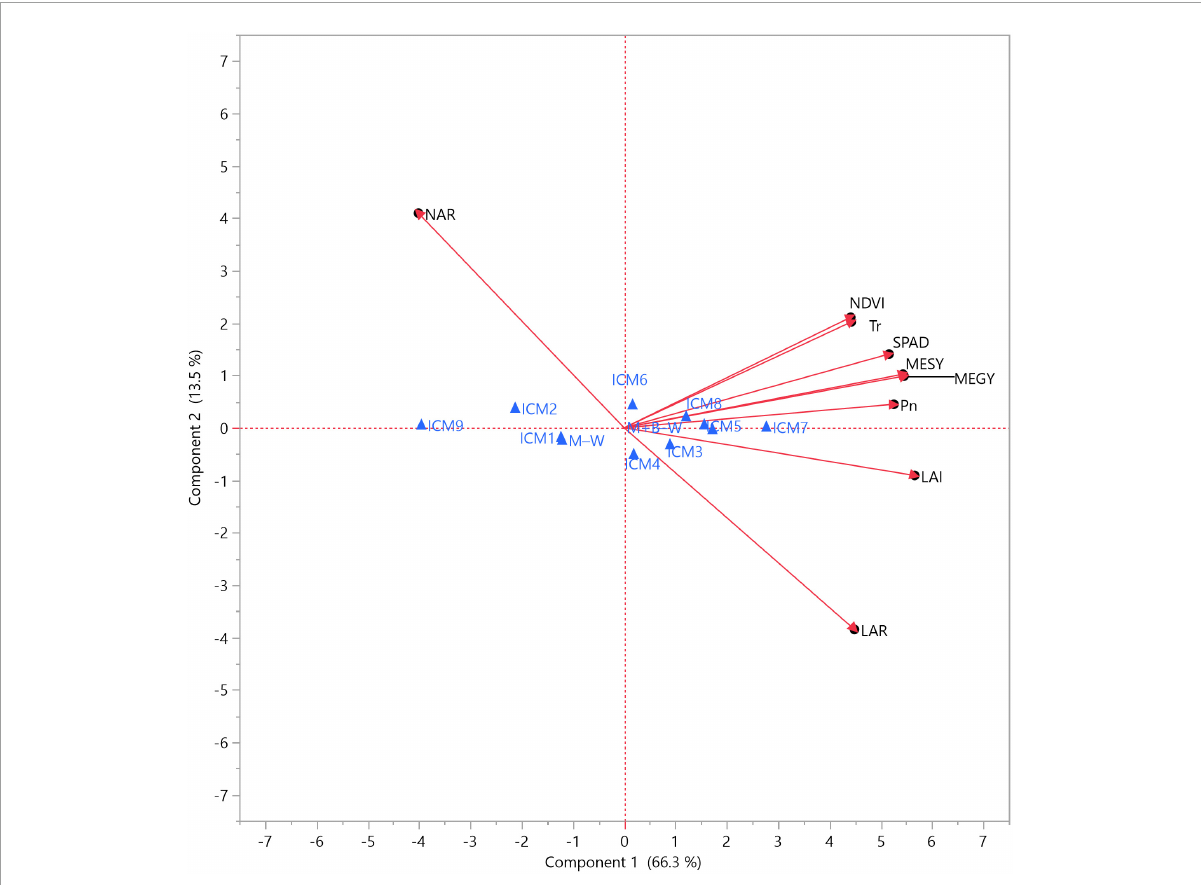
FIGURE6 Principal component analysis (PCA) biplots on impact of ICM and CS on various crop physiological (LAI, LAR, NAR, NDVI, and SPAD at 60 DAS) and photosynthetic characteristics (flowering stage, 60 DAS), MEGY and MESY in maize from two cropping seasons (2019 and 2020). Blue triangle indicates main- and subplot treatments, i.e., CT (ICM 1 –ICM 4 ), CA (ICM 5 –ICM 8 ), and OA (ICM 9 ); maize–wheat cropping system (M–W); maize + blackgram–wheat cropping system (M +